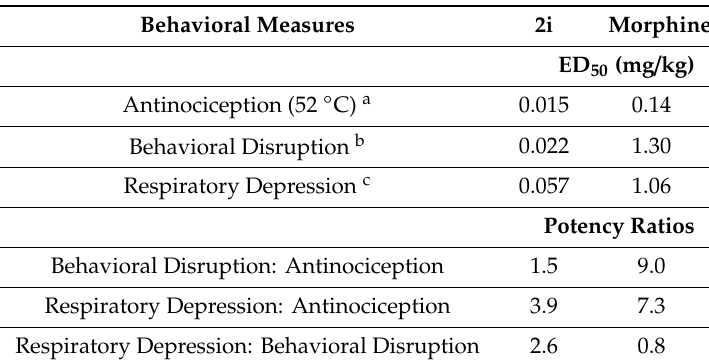
Table 3. ED50 values and ratios of ED50 values for e ff ects measured in squirrel monkeys.